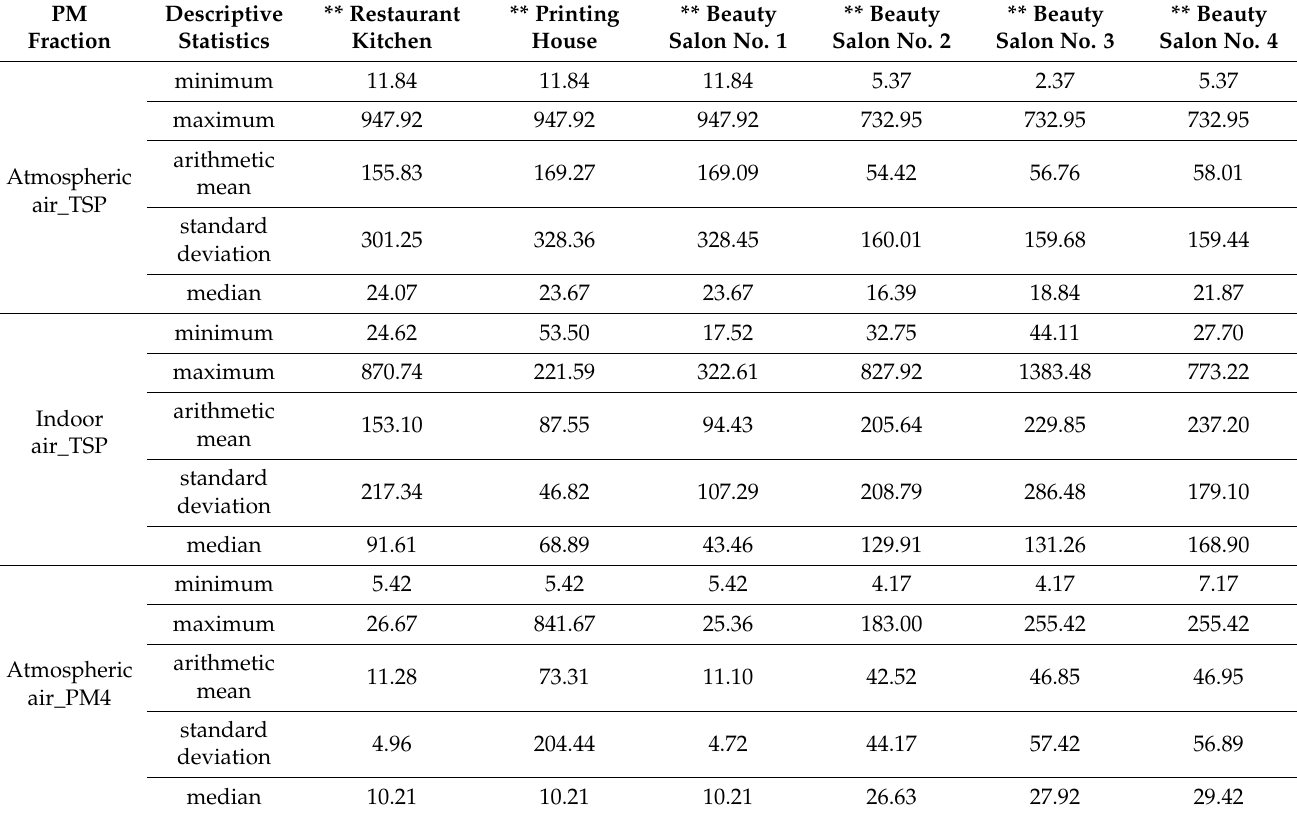
Table 1. Descriptive statistics of the 8 h TSP and PM4 concentration sets (all values are given